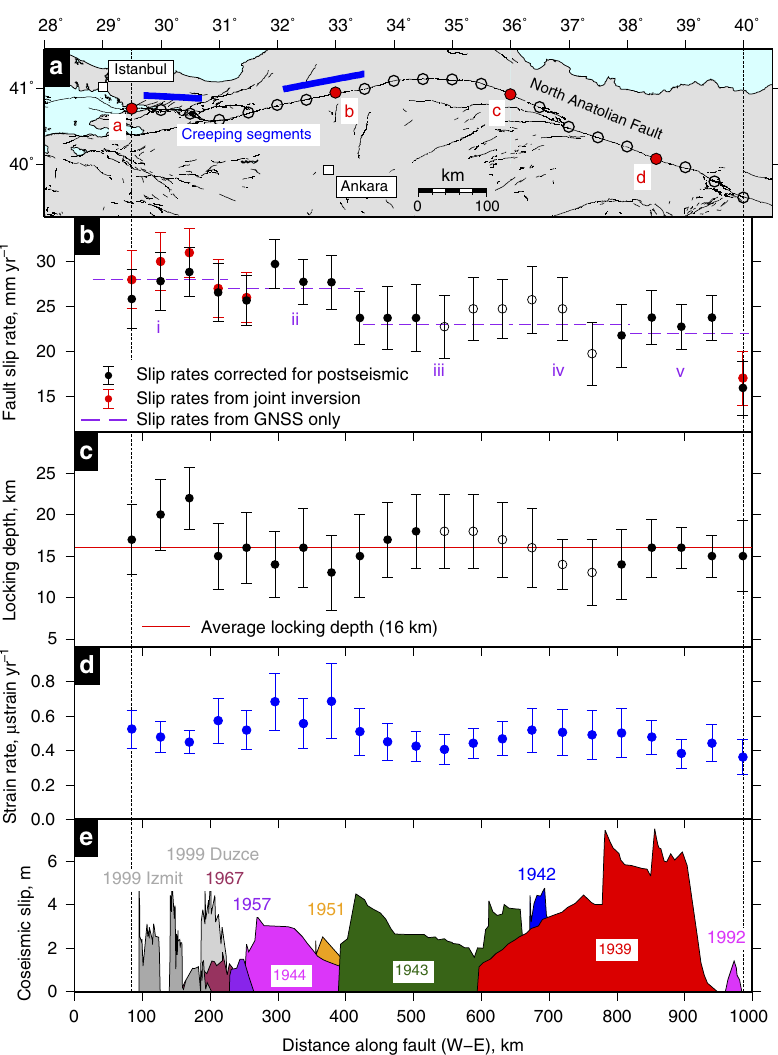
Fig. 3 Along strike variation in fault parameters. The variation in fault slip rate ( b ) and locking depth ( c ) along strike of the North Anatolian Fault (NAF) at the locations indicated by the black circles in a . The error bars represent the 68% con fi dence bound on the parameter estimates. The solid circles are results from pro fi les that are in the high con fi dence polygons indicated in Fig. 1c, while the open circles are pro fi les that are in areas where only ascending or descending data are available. The slip rates are consistent with a constant locking depth of 16 ± 4 km along the entire fault (Supplementary Fig. 9). The purple lines in b are the slip rate estimates from GNSS alone (Supplementary Fig. 10). We use the slip rate and locking depth estimates to calculate the strain rate along the fault ( d ), as described in the text. e The surface coseismic slip distributions of major earthquakes (Mw > 6.5) along the NAF